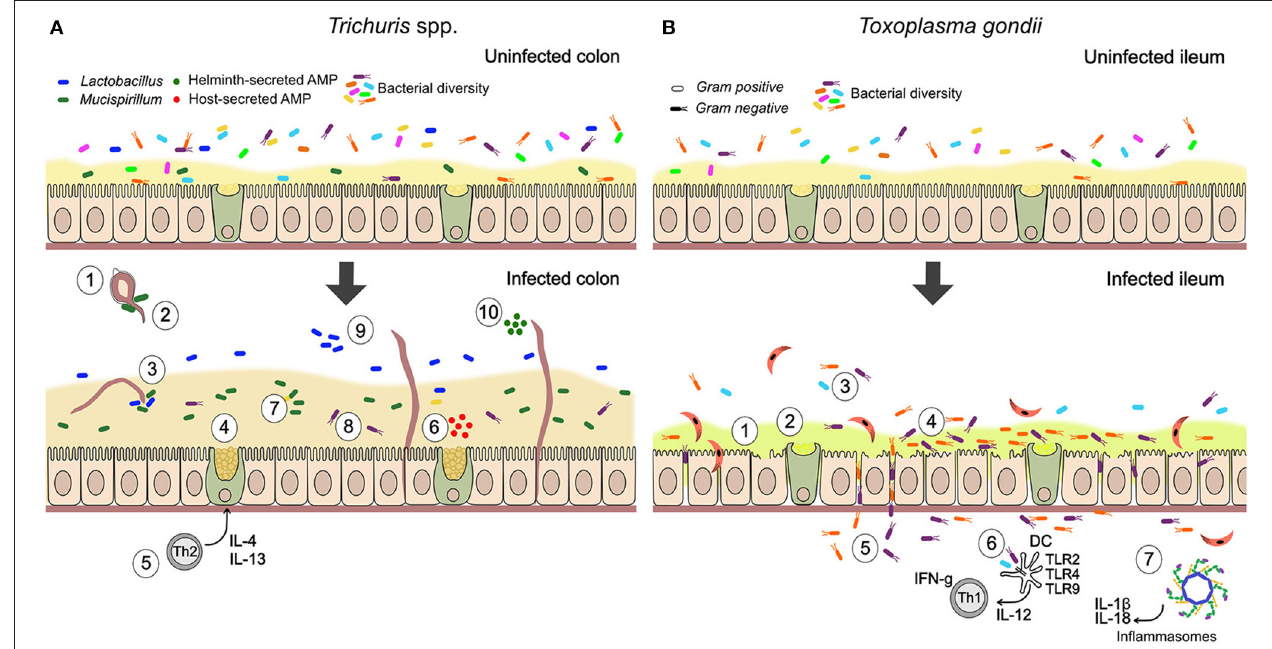
FIGURE 1 | Summary of documented mechanisms by which infection with Trichuris spp. and Toxoplasma gondii may alter the gut microbiota. (A) In Trichuris infection, parasites stimulate an anti-inflammatory mucogenic immune response that may improve barrier function and reduce bacterial-driven inflammation. Direct interactions through physical attachment and secreted molecules are also likely. (1) Gut bacteria attach to polar caps and allow egg-hatching (Hayes et al., 2010). (2) T. muris -induced changes to the gut microbiota inhibit hatching of further T. muris eggs (White et al., 2018). (3) T. muris can ingest bacteria from their environment (White et al., 2018). (4) Mucin expression changes from MUC2 to MUC5AC, altering physical properties of the mucus (Hasnain et al., 2013). (5) Trichuris drives a Th2-mediated mucogenic response, leading to goblet cell hyperplasia and increase in mucus volume (Broadhurst et al., 2010, 2012). (6) Infection induces production of antimicrobial peptides (AMPs) by goblet cells (e.g., Ang4; D’Elia et al., 2009). (7) Infection drives expansion of Mucispirillum , a mucolytic genus of bacteria (Wu et al., 2012; Holm et al., 2015; Houlden et al., 2015). (8) Mucus can reduce adherence of bacteria to the epithelium, in the context of inflammatory disease (Broadhurst et al., 2012). (9) Infection drives expansion of Lactobacillus and other changes in community structure, including reduced microbial diversity (Holm et al., 2015; Houlden et al., 2015). (10) Helminths directly secrete AMPs in excretory-secretory products (Abner et al., 2001). (B) During T. gondii infection, inflammatory processes play an important role in parasite-microbiota interactions and their consequences. Degradation of barrier function by parasites allows bacterial translocation and consequent inflammation, while microbe-driven pro-inflammatory responses contribute to anti-parasite immunity. (1) Blunted villi and epithelial damage (Cohen and Denkers, 2014; Trevizan et al., 2016). (2) Change to more acidic and neutral mucins, thought to increase mucus fluidity (Trevizan et al., 2016). (3) Reduction in bacterial diversity (Heimesaat et al., 2006). (4) Increase in adherent Gram-negative bacteria ( E. coli and Bacteroides/Prevotella ) relative to Gram-positive (Heimesaat et al., 2006). (5) Bacterial translocation to lamina propria (Heimesaat et al., 2006; Hand et al., 2012; Cohen and Denkers, 2014). (6) Stimulation of protective pro-inflammatory immune response against parasites by bacterial TLR stimulation (Benson et al., 2009). With high dose infection, inflammatory disease (ileitis) results from a cytokine storm (Hand et al., 2012). (7) T. gondii infection activates NLRP1 and NLRP3 inflammasomes (Ewald et al., 2014; Gorfu et al., 2014), driving production of pro-inflammatory cytokines, IL-18 and IL-1 β , that mediate resistance to the parasite but are expected to also affect gut microbes.